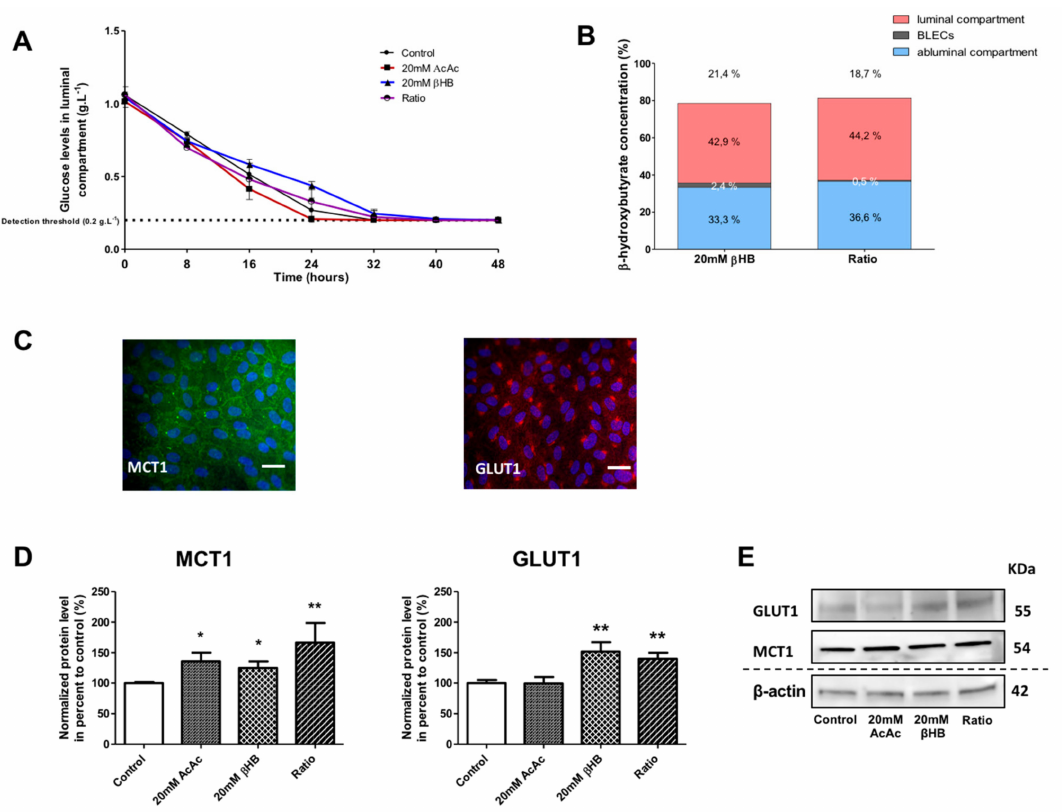
Figure 2. Effect of KBs on the human in vitro BBB model. ( A ) BLECs were incubated with various concentrationsofKBsfor48h: 20mMAcAc, 20mM β HB,orratio(20mMAcAc / 20mM β HB).Theglucose concentration was measured in the apical compartment every 8 h. ( B ) The β HB concentration was measured in the apical and basolateral compartments and in BLECs. The data are represented as mean ± SEM obtained from three independent experiments. ( C ) The presence of MCT1 (green) and GLUT1 (red) in the BLECs was performed using immunostaining. Nuclei were stained with Hoechst reagent, and appear in blue. Scale bar: 50 µ m. ( D ) The e ff ects of KBs on MCT1 and GLUT1 protein levels were analyzed by Western blot. The protein level was normalized using β -actin. The protein data represent the mean ± SEM obtained from at least three independent experiments relative to control conditions (* p < 0.05, ** p < 0.01). ( E ) The images are representative of at least three independent